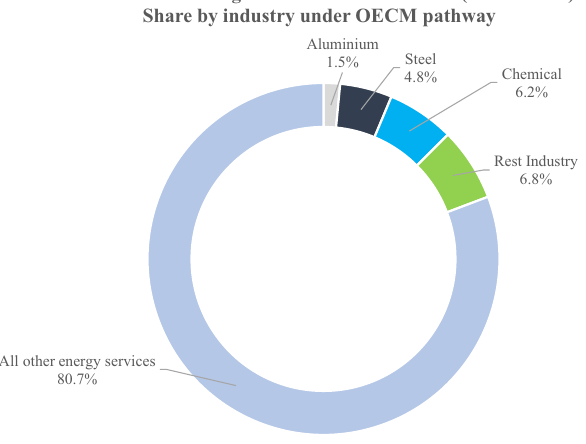
Fig. 2 Global cumulative energy-related CO 2050)—shares for the aluminium, steel, and chemical